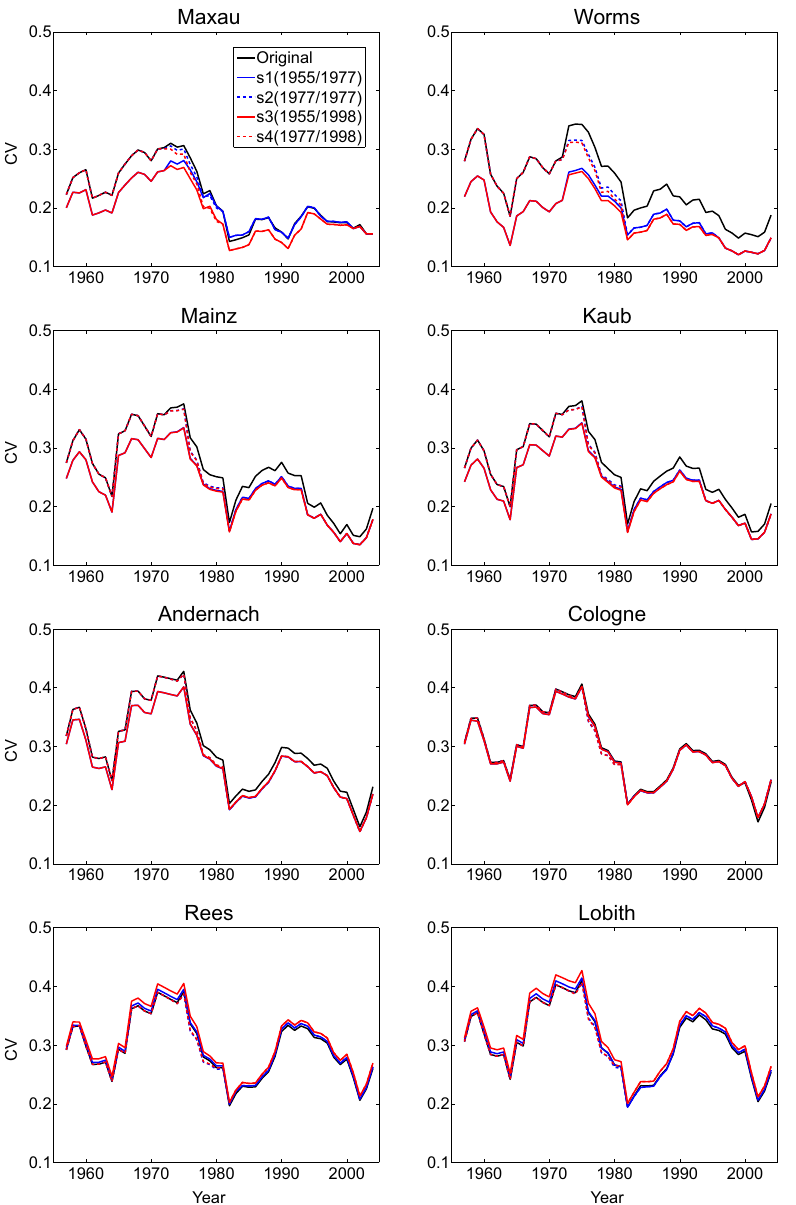
Fig. 3. Ten-year running mean of the coefficient of variation (CV) of annual maximum flows at Rhine gauges.